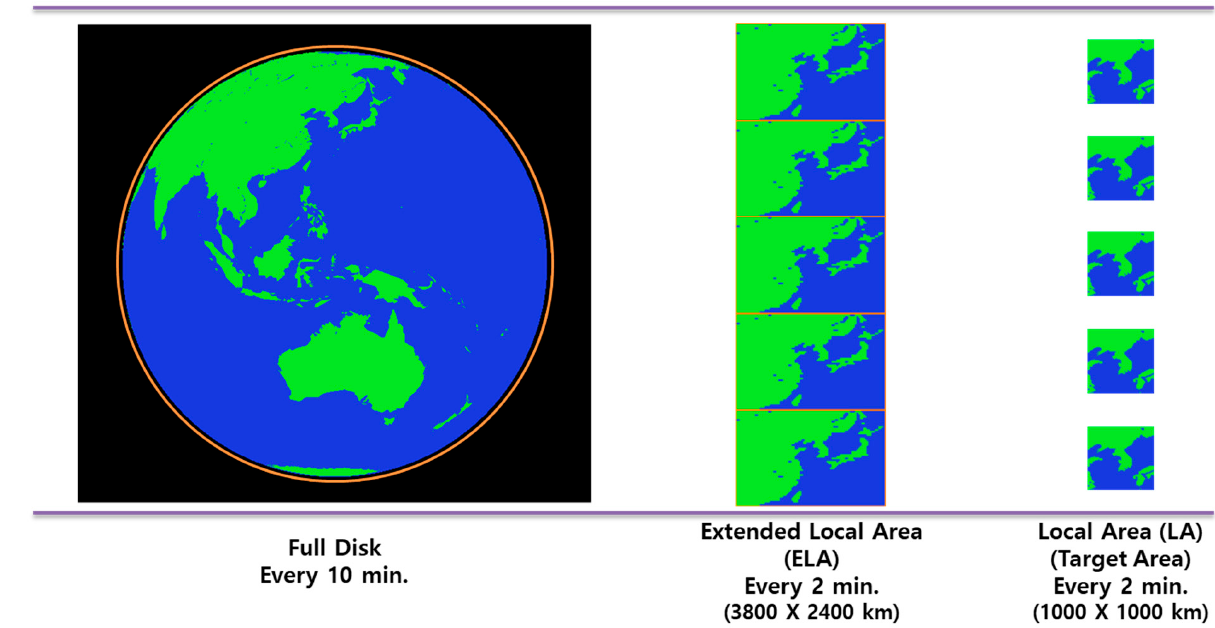
Figure 4. GK2A AMI observation areas and frequencies on one timeline of 10 min.